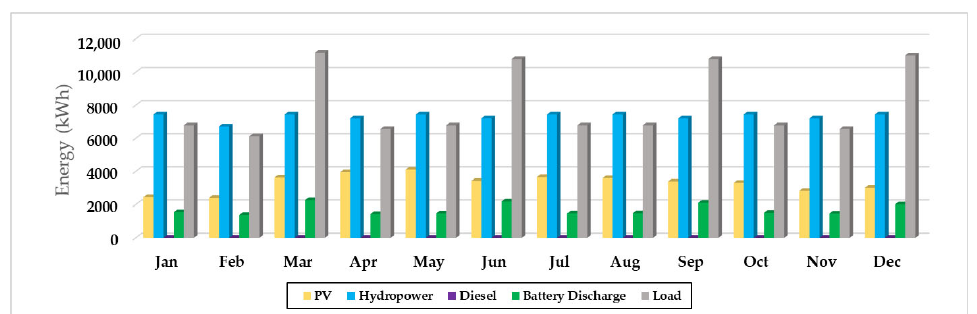
Figure 15. Energy generated by HREM components—Solution A.